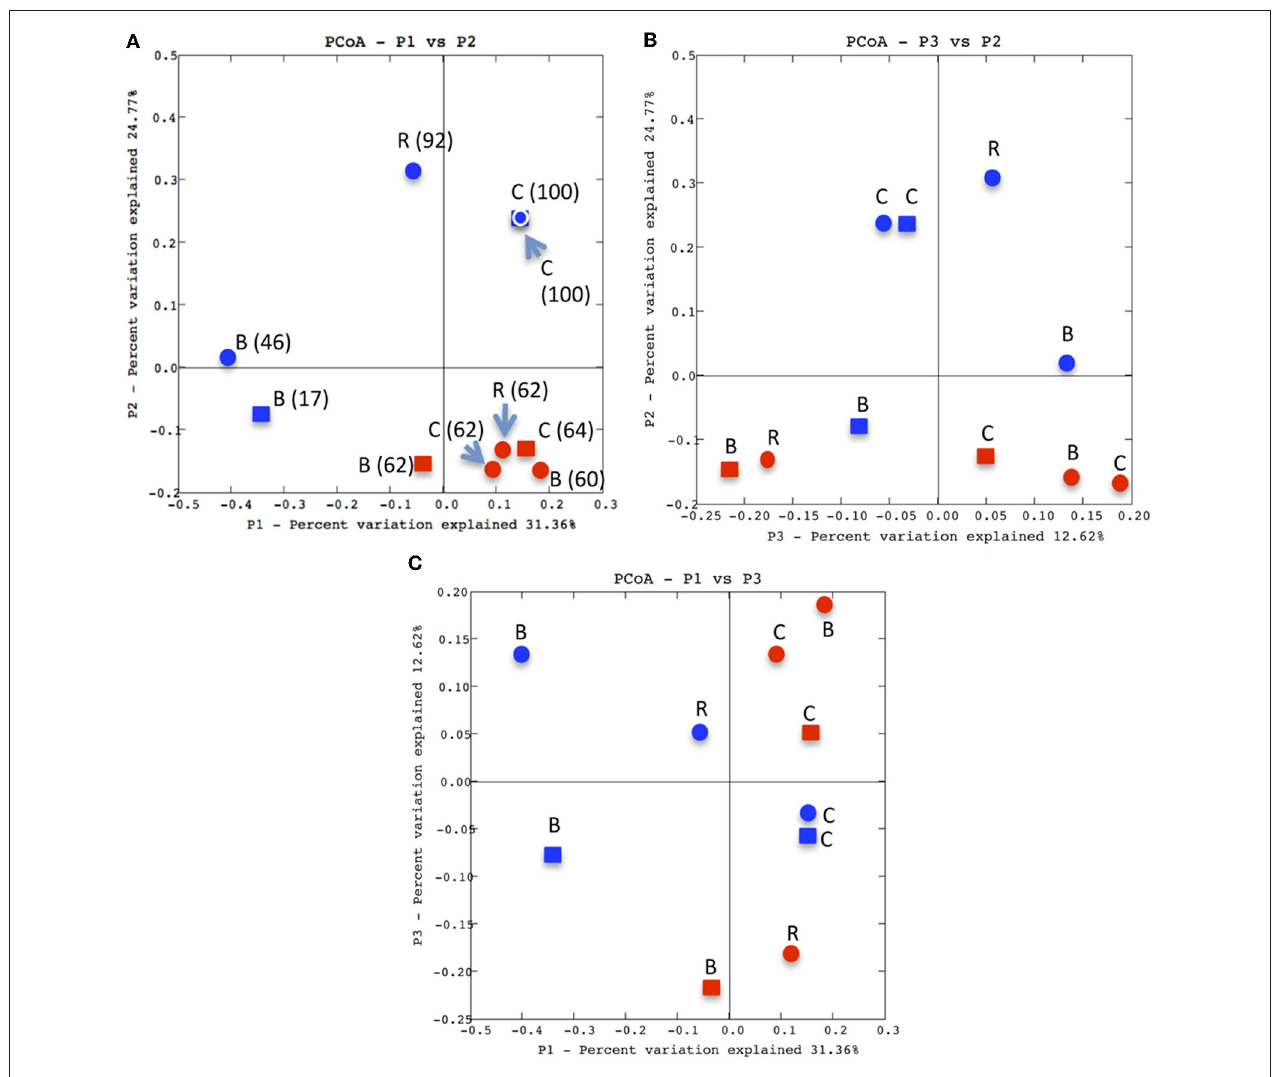
FIGURE 7 | Unifrac PCA analyses of archaeal amoA libraries. Panels A–C are: P1 vs . P2, P3 vs . P2 and P1 vs . P3, respectively. Samples are coded as: mesophilic, red, mature, blue, sheep manure, circles, cow manure, squares,